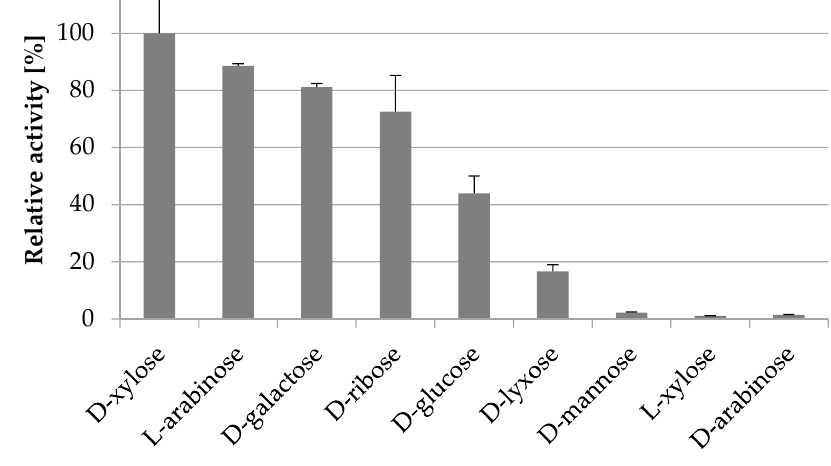
Figure 5. Relative activity of Ct XR at 0.5 M substrate concentration. 0.4 mM NADPH was used as cofactor in a 50 mM bis-tris buffer, pH 6.5, at 30